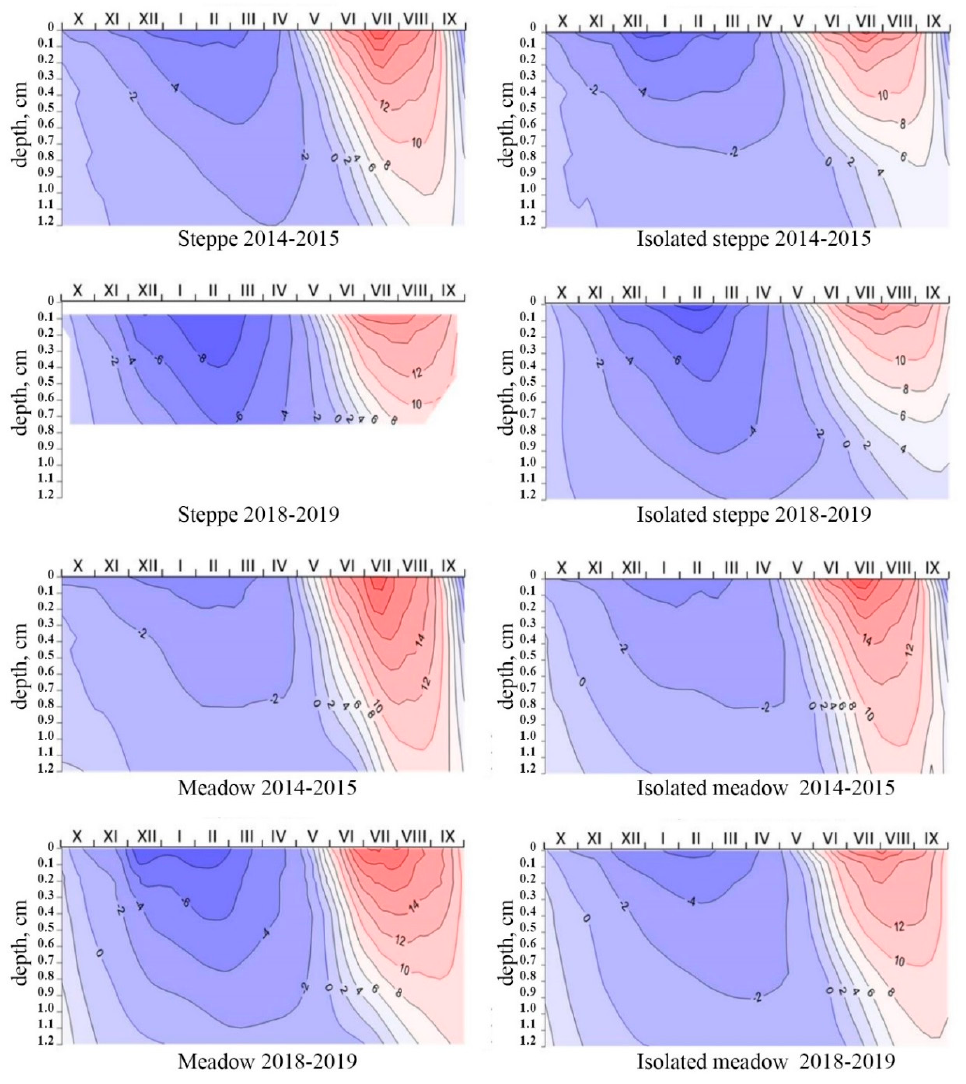
Figure 10. Thermoisoplets of alas